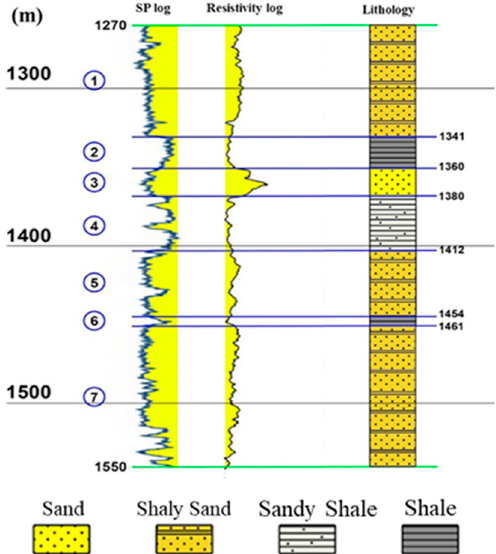
Figure 2. The analyzed results of the lithology of the sublayers in the YTP formation at well Y-15.